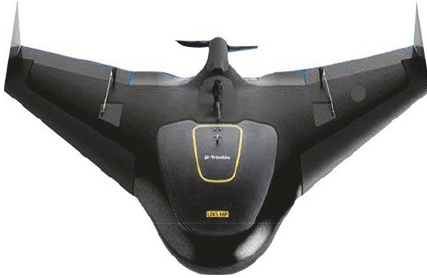
Figure 16: Structure of antenna